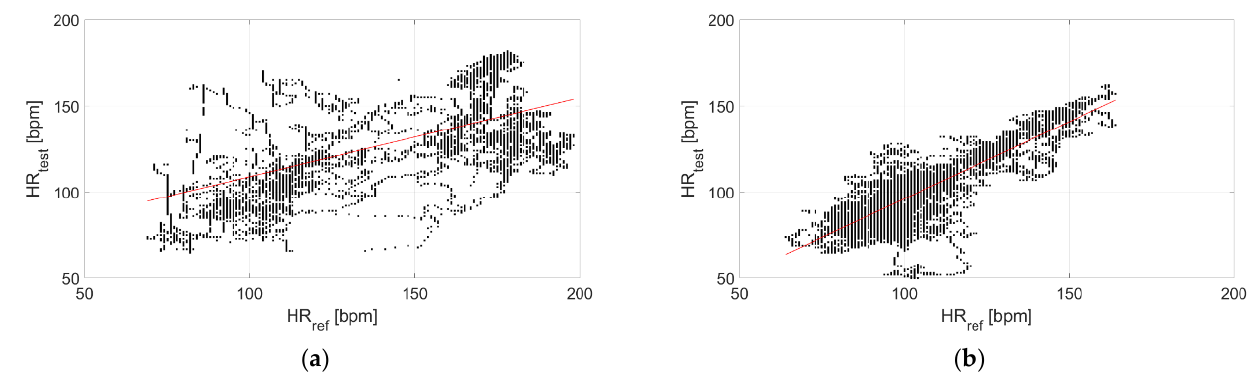
Figure 10. Correlation of measurements performed through Polar Vantage V2 with respect to the reference sensor (Polar H10) related to ( a ) In-water and ( b ) Dry acquisitions, including recordings both at rest and during moderate physical activities. Table 3. Metrological performance of the tested smartwatches in terms of measurement accuracy (µ) and precision (±2 σ ), confidence interval at 95% (CI95%), mean absolute percentage error (MAPE), and Pearson’s correlation coefficient ( ρ )—dry vs. in-water conditions.